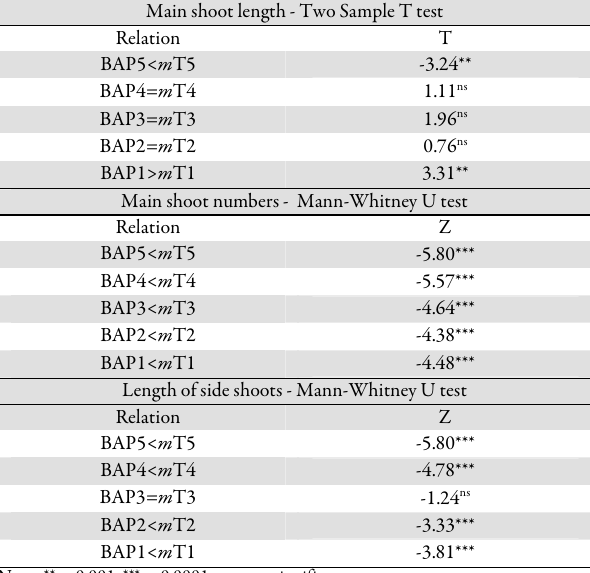
Tab. 2. The plants shoot analyses between the two cytokinin treatments in multiplication experiment